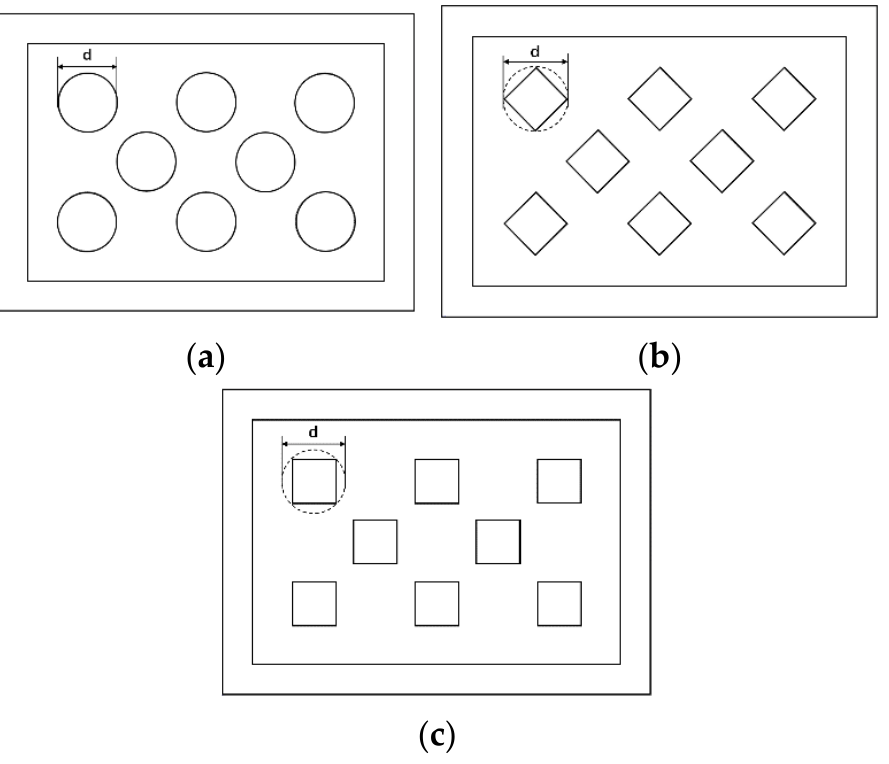
Figure 9. Cross-section of pin–fins: ( a ) round; ( b ) diamond; and ( c ) rectangle.